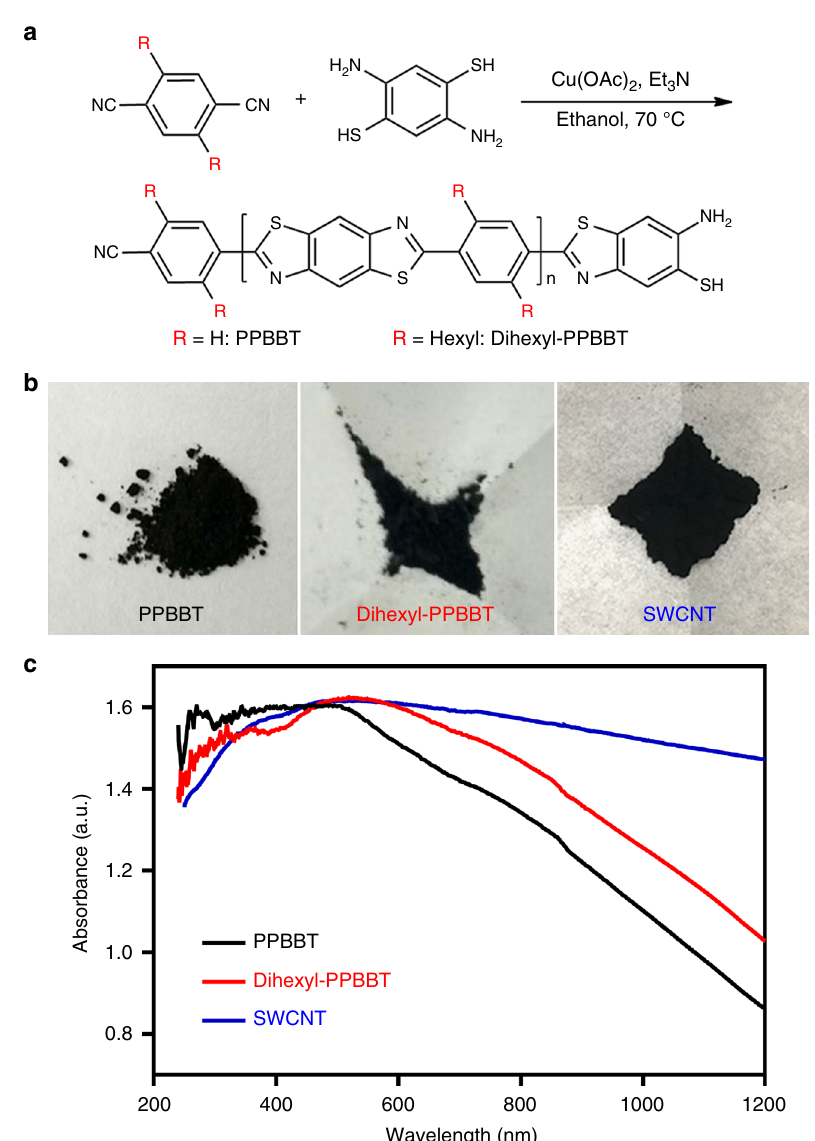
Fig. 1 Syntheses and optical properties of PPBBT (or Dihexyl-PPBBT). a Synthetic routes for PPBBT and its dihexyl derivative Dihexyl-PPBBT. b Photographs of PPBBT, Dihexyl-PPBBT, and SWCNT powders. c UV-Vis-NIR absorption spectra of PPBBT, Dihexyl-PPBBT,